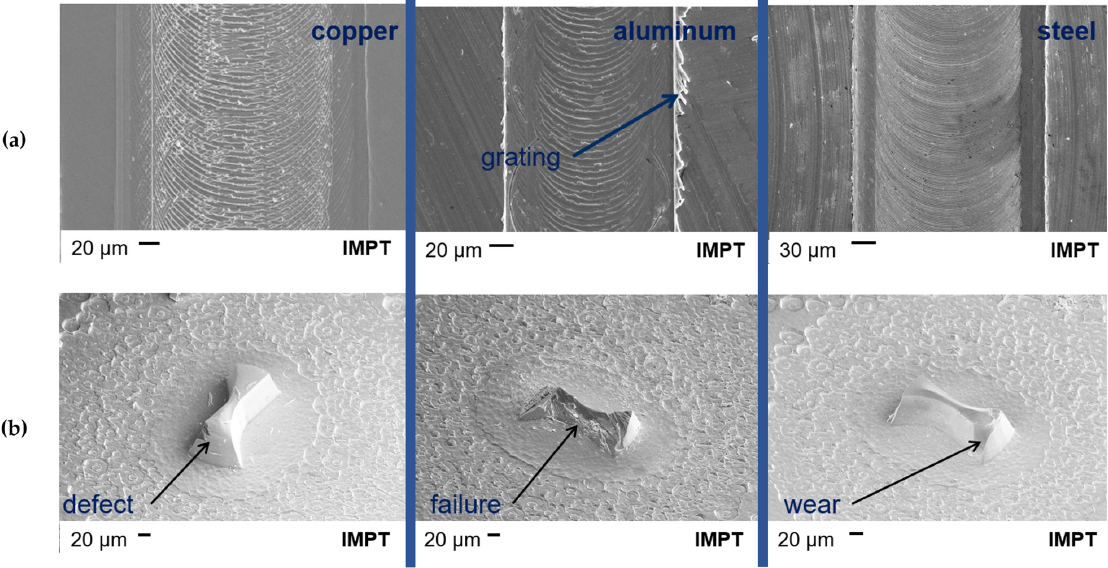
Figure 9. Shown is ( a ) an SEM image of a milled track in copper and ( b ) a detailed image of the